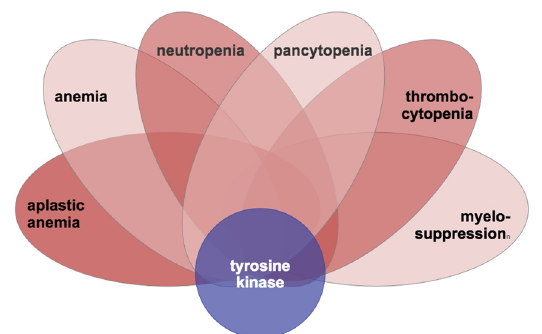
Figure 3. Conceptual overview of hub node network analysis to construct neighborhoods that find more distant or less represented connections to tyrosine kinase in the knowledge graph. The six leaves shown represent the hub nodes (aplastic anemia, anemia, neutropenia, pancytopenia, thrombocytopenia, and myelosuppression) used to generate hub neighborhoods for link prediction. Link prediction and SemNet simulation predicted disease or syndrome (DSYN) nodes related to tyrosine kinase that could be relevant adverse events (AEs) for CML patients on TKI therapy.